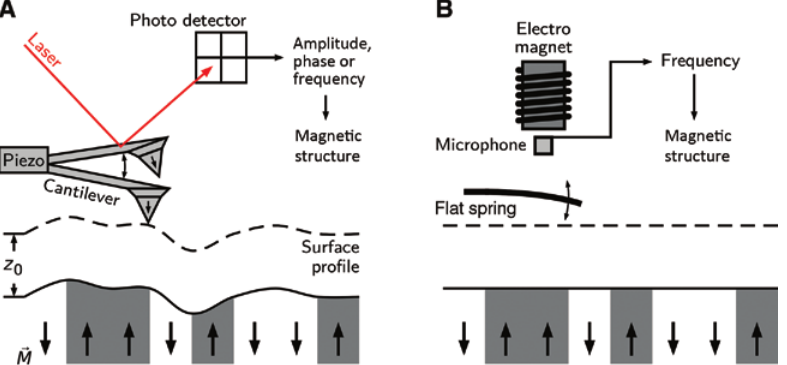
Figure 1: (A) Basic MFM principle using a permanently magnetized oscillating cantilever driven by a bimorph piezoelectric plate to inves- tigate microscopic magnetic structures. The oscillation is analyzed in amplitude, phase, or frequency via a reflected laser beam applying a photo detector. (B) Acoustic MFM model principle using an electromagnet to cause permanent oscillation of a non-ferromagnetic flat spring to analyze magnetic samples investigating the force gradient dependent frequency shift applying a microphone.